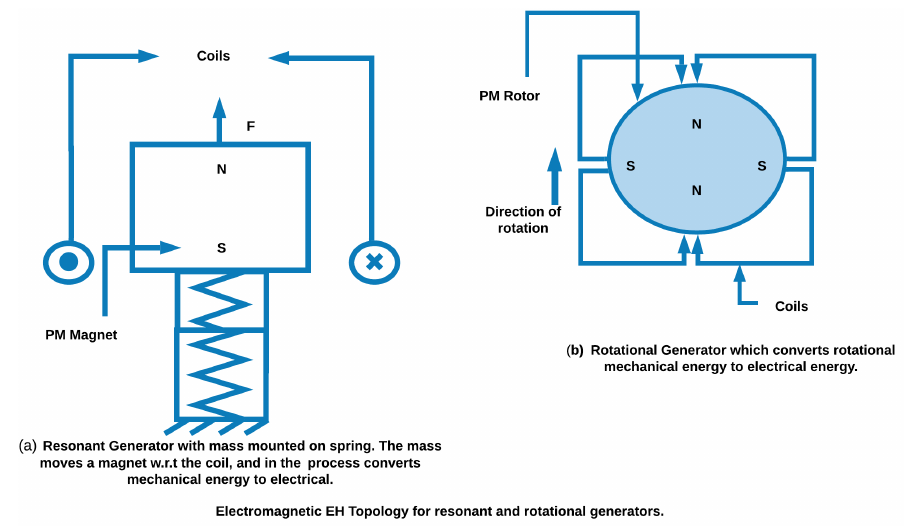
Figure 4. Electromagnetic Energy Harvesting (EH) Topology for resonant and rotational generators.